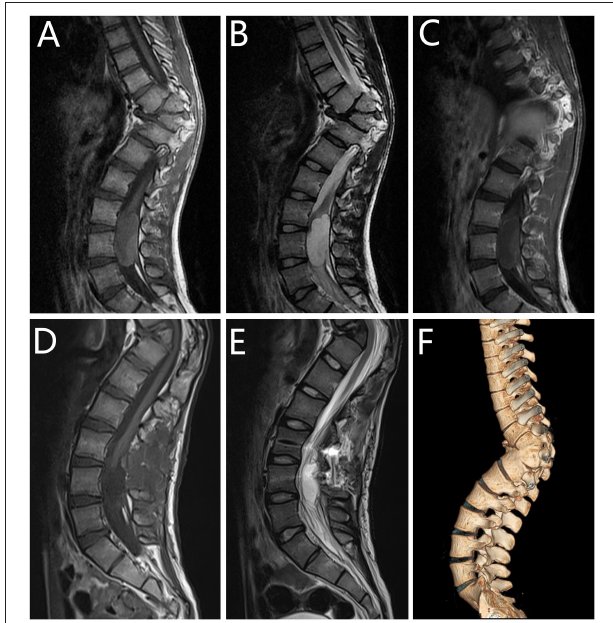
FIGURE 2 | Radiographic images of case 3. (A–C) Pre- and (D,E) postoperative magnetic resonance imaging (MRI) scans revealed a cystic lesion dorsal to the L3-L5 spinal cord. Three-dimensional reconstruction (F) illustrated scoliosis in the thoracolumbar region. Sagittal MRI scan demonstrated isointense signal on (A) T1-weighted imaging (T1WI) and hyperintense signal on (B) T2-weighted imaging (T2WI). (C) T1WI with gadolinium administration showed no enhancement after administration of the intravenous contrast material on T1WI. After 6 months of follow-up, the re-examination MRI showed that the lesion was totally resected.